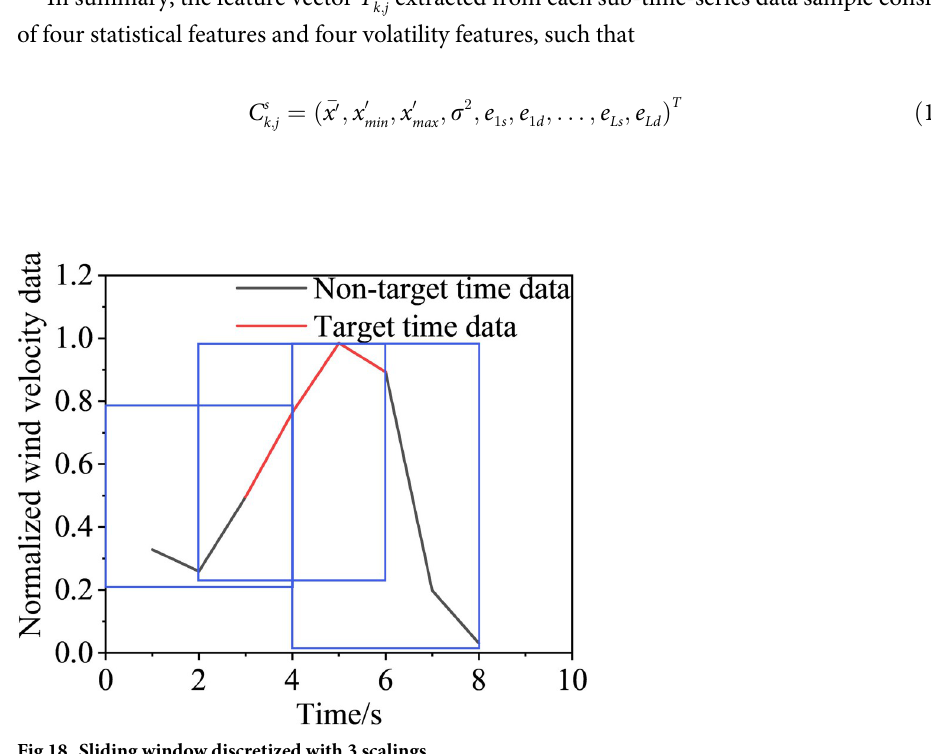
Fig 18. Sliding window discretized with 3